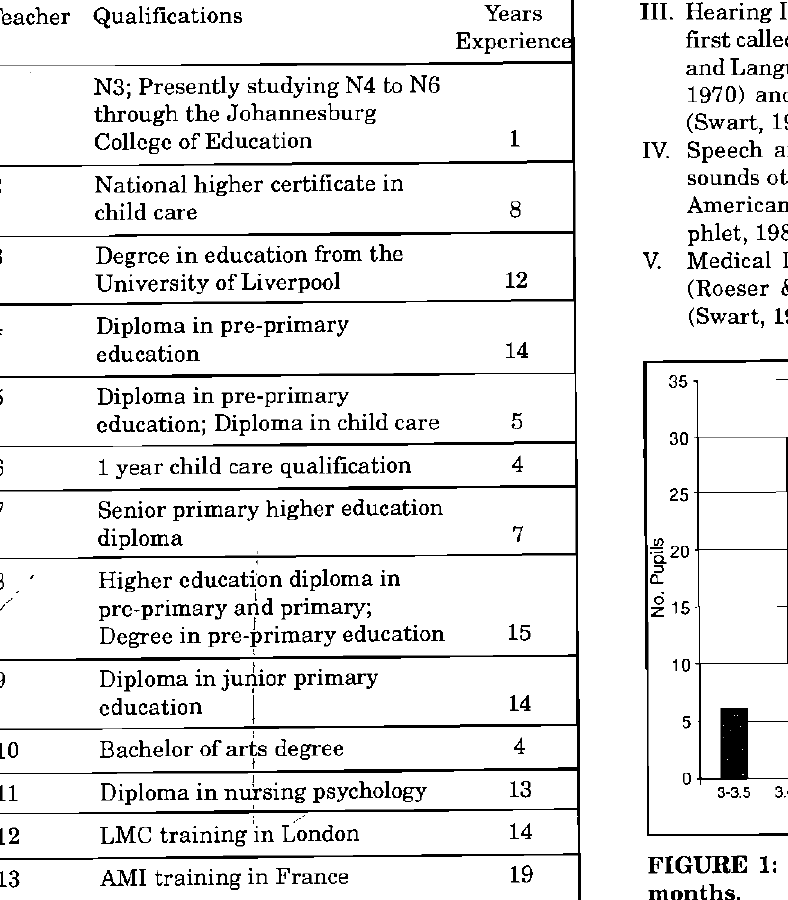
FIGURE 1: Pupil - Age Distribution in years and months.